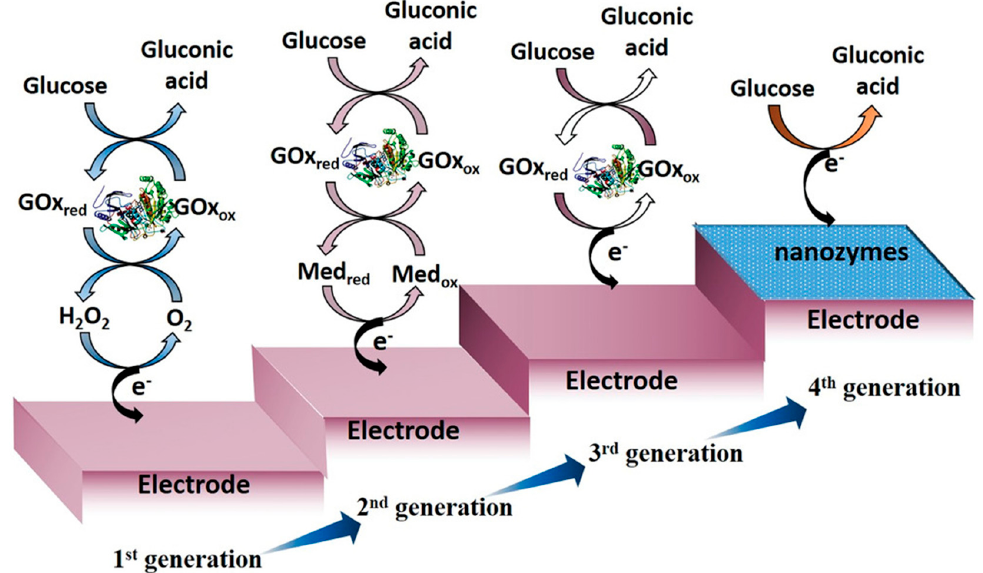
Figure 1. Schematic representation of the working principle of different generations of electrochemical glucose sensors. Figure reproduced with permission from ref. [16].